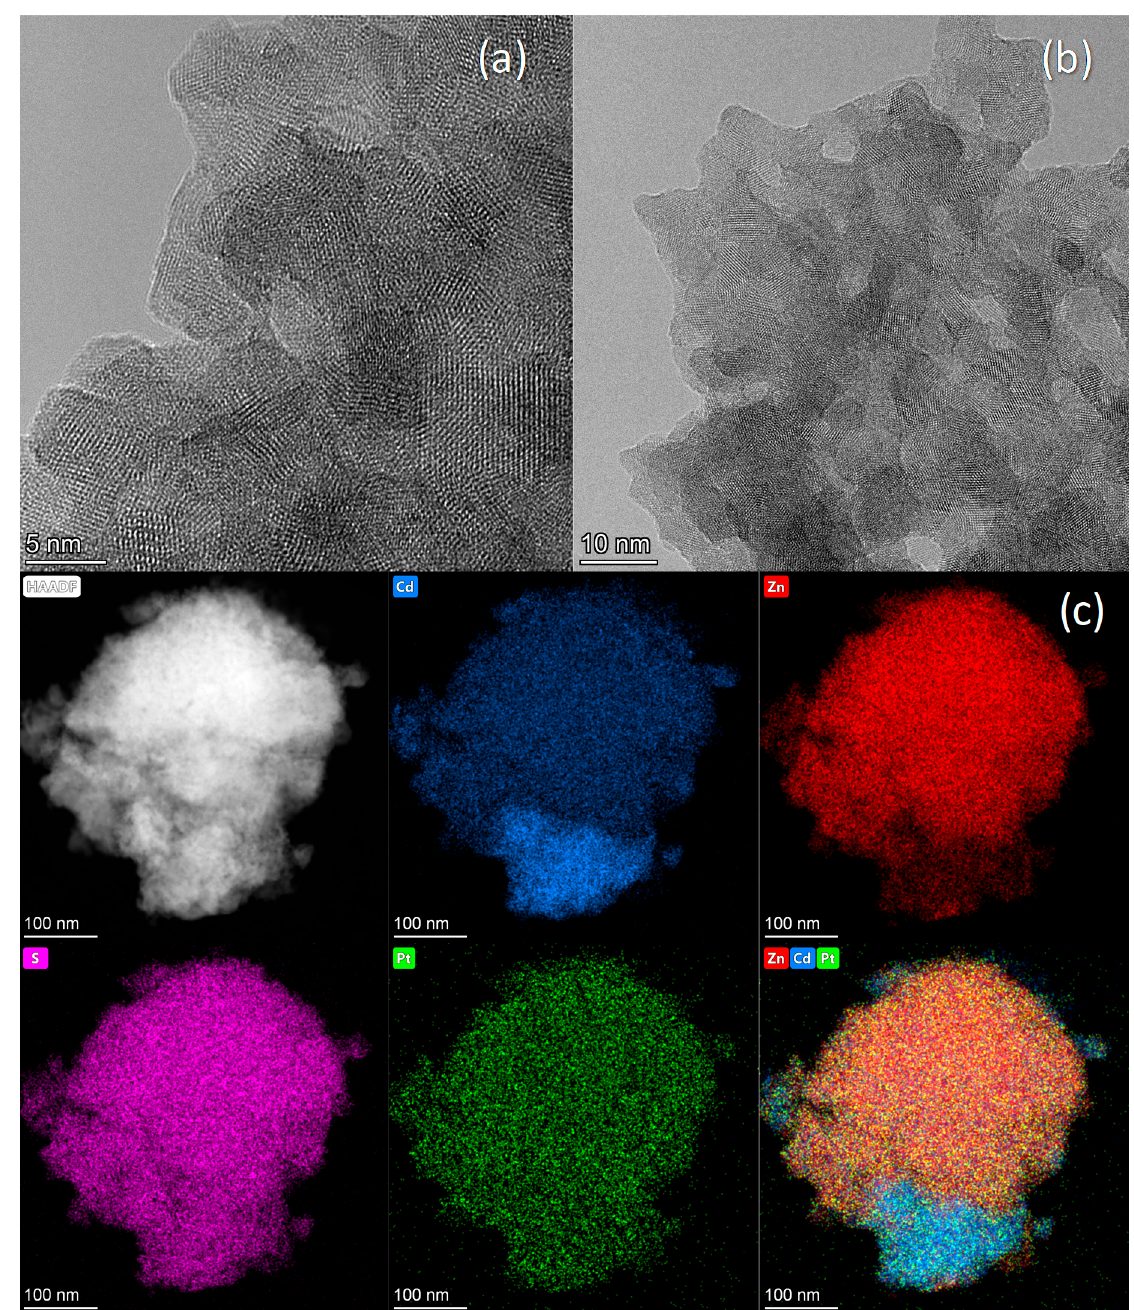
Figure 3. ( a , b ) HRTEM and ( c ) HAADF-STEM images with EDX with elemental mapping of the synthesized sample.